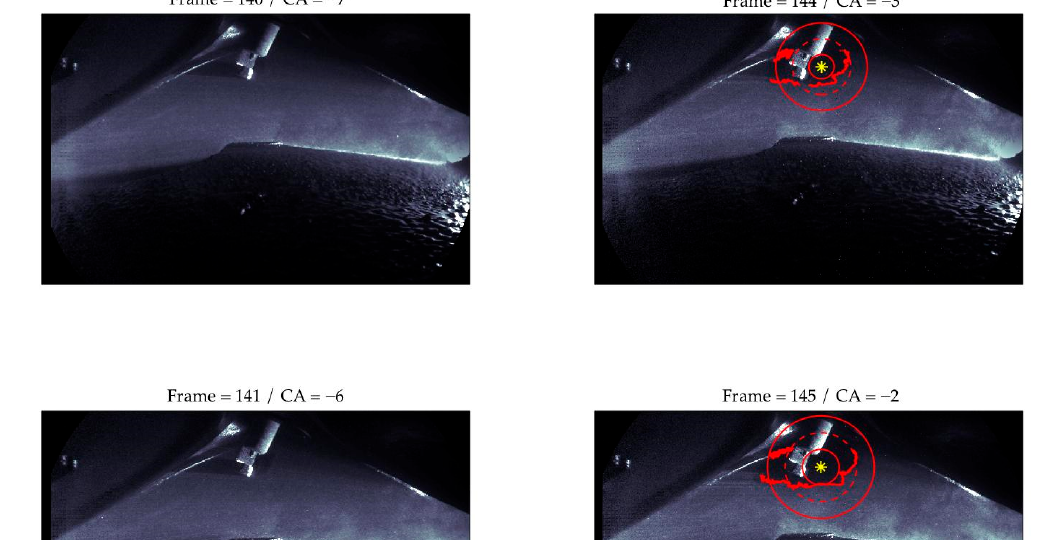
Figure 14. Cycle 59. Background corrected images of turbulent flame from 1 to 8 CAD after TDC firing. Superimposed geometric properties: flame edges, flame center, min, max, and average radii. Engine operation: 1000 RPM, wide open throttle.